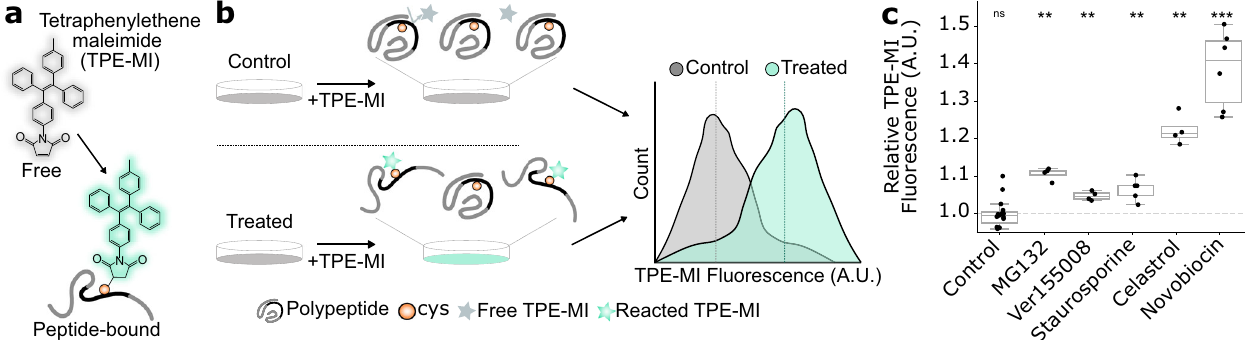
Fig. 1 Pharmacological stimuli result in net increases in the TPE-MI reactivity of cellular proteins. a Structure of tetraphenylethene conjugated to a maleimide (TPE-MI). TPE-MI is inherently non- fl uorescent in the free form, forming a fl uorescent conjugate upon binding exposed thiol residues within polypeptides. b Method schematic for quantifying global proteome conformation. Neuro-2a cells were treated with MG132, VER155008, staurosporine, celastrol, novobiocin, or the vehicle control (milliQ water in the case of Novobiocin, else DMSO), before labeling with TPE-MI. Cells were then analyzed via fl ow cytometry. c Median TPE-MI fl uorescence measured at 450 nm, normalized to the vehicle-treated control population. Shown are boxplots overlayed with individual datapoints of at least four biological replicates (dots; novobiocin n = 6, staurosporine n = 5, otherwise n = 4), * p < 0.05, ** p < 0.01, *** p < 0.001 according to one-sample t -test against a hypothetical mean of 1. In c , individual points are overlayed on boxplots displayed as follows: center line corresponds to the median; box limits display upper and lower quartiles; and where shown, whiskers extend to the last or fi rst data point that is within 1.5× the interquartile range of the box limits in the upper and lower directions, respectively. Source data are provided as a Source Data fi